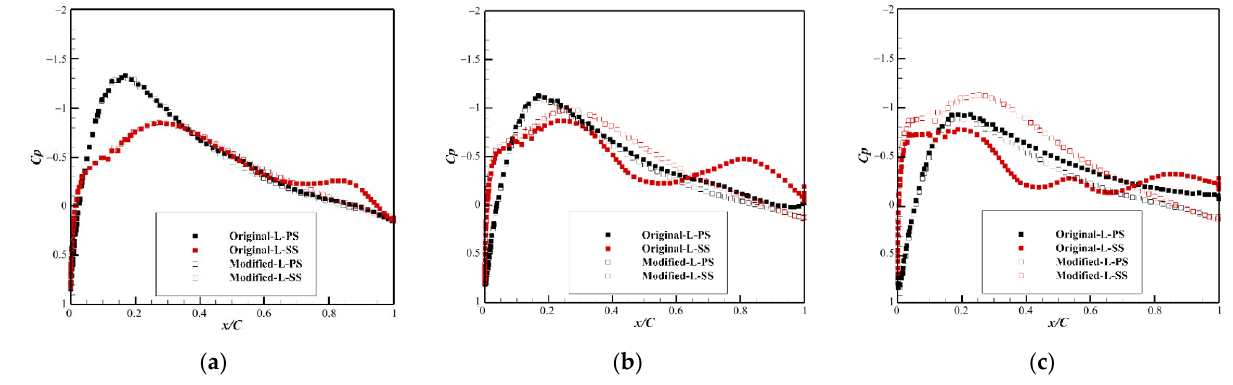
Figure 21. C p distributions on right vertical tail part of the original and modified models: β = ( a ) 0°, ( b ) 2°, and ( c ) 4°.